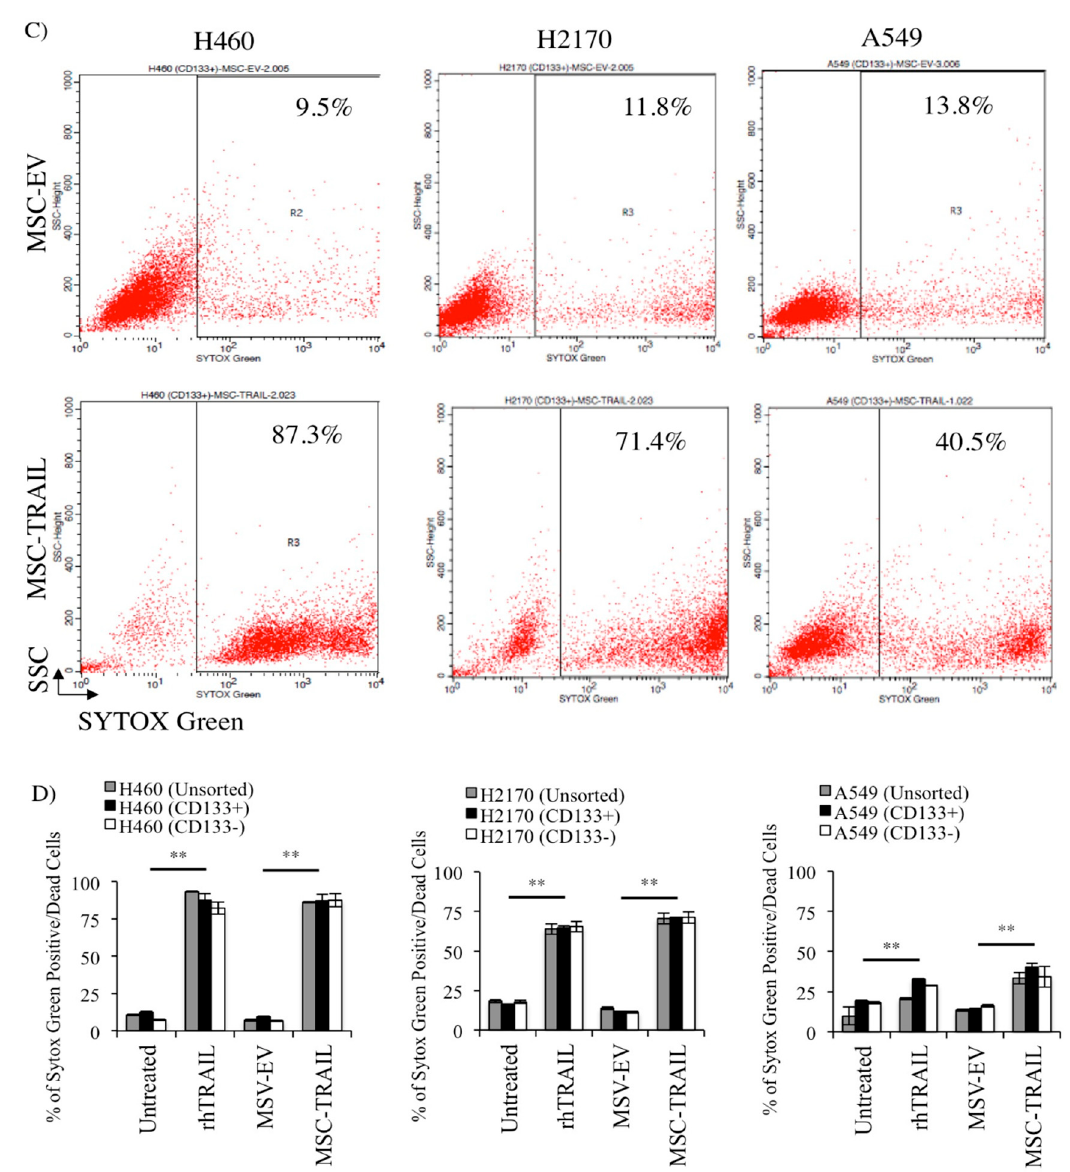
Figure 6. In vitro apoptosis and cell death of CD133 + CSCs by MSC-TRAIL. ( A ) Histograms illustrating the percentage of annexin V expression in CD133 + NSCLC-derived CSCs co-cultured with either MSC-EV or MSC-TRAIL (NSCLC-cell-to-MSC ratio of 1:1) for 72 h, and ( B ) bar chart depicting the percentage of annexin V in CD133 + CSCs and controls (CD133 − and unsorted). ( C ) Flow cytometry gating to analyze the percentage of cell death using the Sytox Green assay in CD133 + NSCLC-derived CSCs and controls (CD133 − and unsorted) co-cultured with either MSC-EV or MSC-TRAIL. ( D ) MSC-TRAIL significantly induced cell death in the CD133 + CSCs isolated from H469 and H2170, equally as prominent as the e ff ect by rhTRAIL treatment, when compared to the controls (MSC-EV and untreated) (** p < 0.001; t -test).